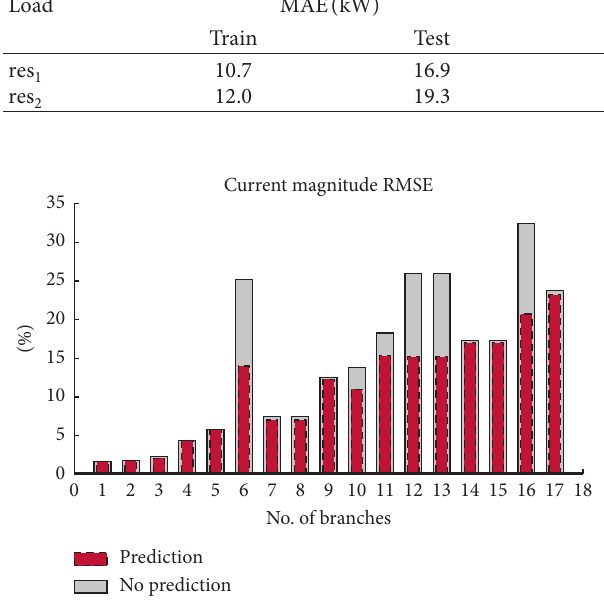
Table 3: Performance of the neural load forecasting models for the residential aggregated loads (training and test). Load